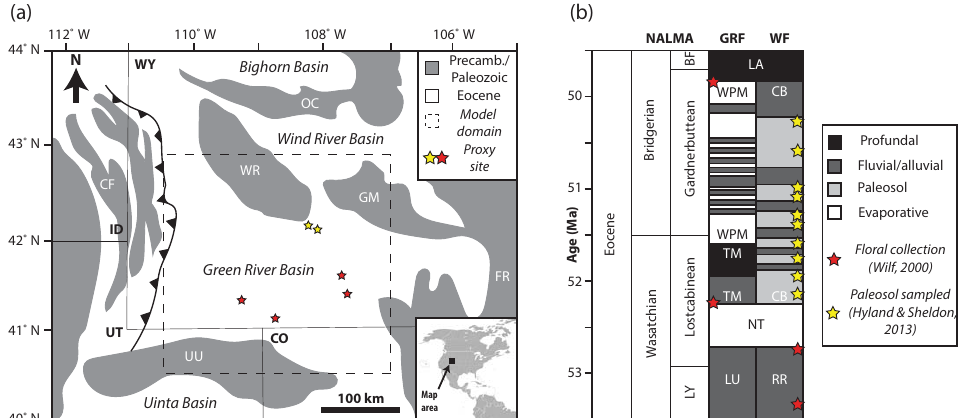
Figure 1. Map and stratigraphy of the Green River Basin. (a) Map of the region, showing major sedimentary basins and topographic highs. Stars show proxy record sampling sites (paleosols in yellow, paleoflora in red), and the dashed box is the sampling region for modern climate stations and the downscaling domain for both models. CF is the Cordilleran fold-thrust belt, UU is the Uinta uplift, WR is the Wind River uplift, OC is the Owl Creek uplift, GM is the Granite Mountains, and FR is the Front Range. (b) Simplified stratigraphy of the central to eastern GRB, showing facies for the Green River Formation (GRF) and the equivalent and interfingering Wasatch Formation (WF) based on the work of Smith et al. (2015) and Hyland and Sheldon (2013). LY is the Lysitean, BF is the Blacksforkian, LU is the Luman Member, NT is the Niland Tongue, TM is the Tipton Member, WPM is the Wilkins Peak Member, LA is the Laney Member, RR is the Ramsey Ranch Member, and CB is the Cathedral Bluffs